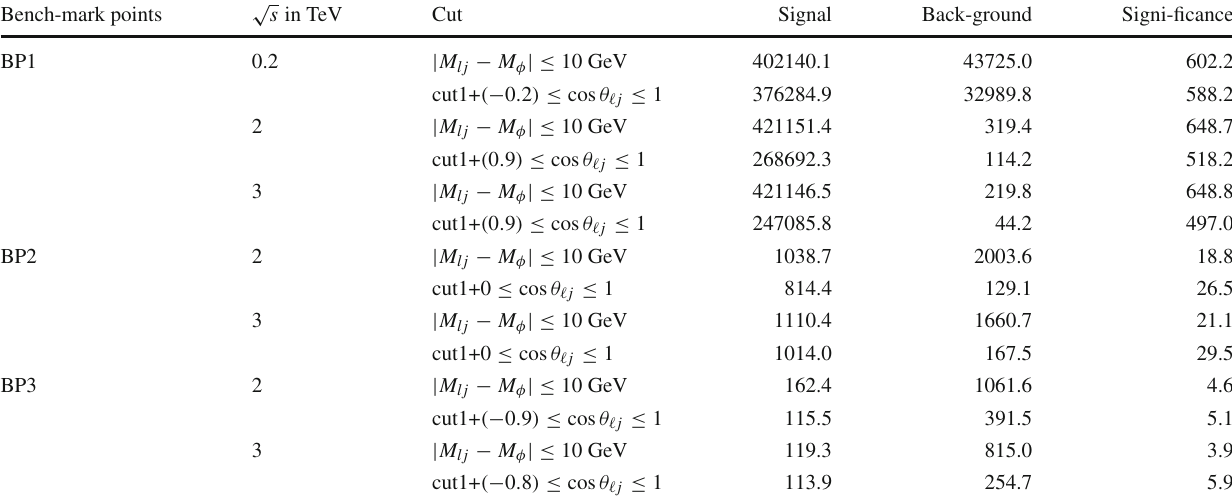
/ 3 ) c with luminosity 100 fb − 1 at e – γ collider 3 μ